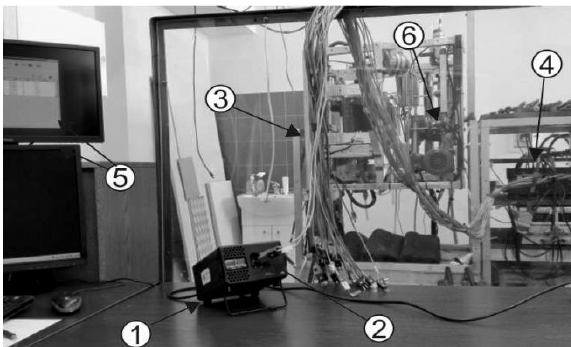
Fig. 4. A view of the experimental setup for temperature calibration: 1 - an instrument for calibration of thermocouples (a calibrator), 2 - thermocouples, 3 - compensation cables, 4 - a data acquisition station, 5 - a PC computer with data visualization and an acquisition software, 6 - an absolute pressure